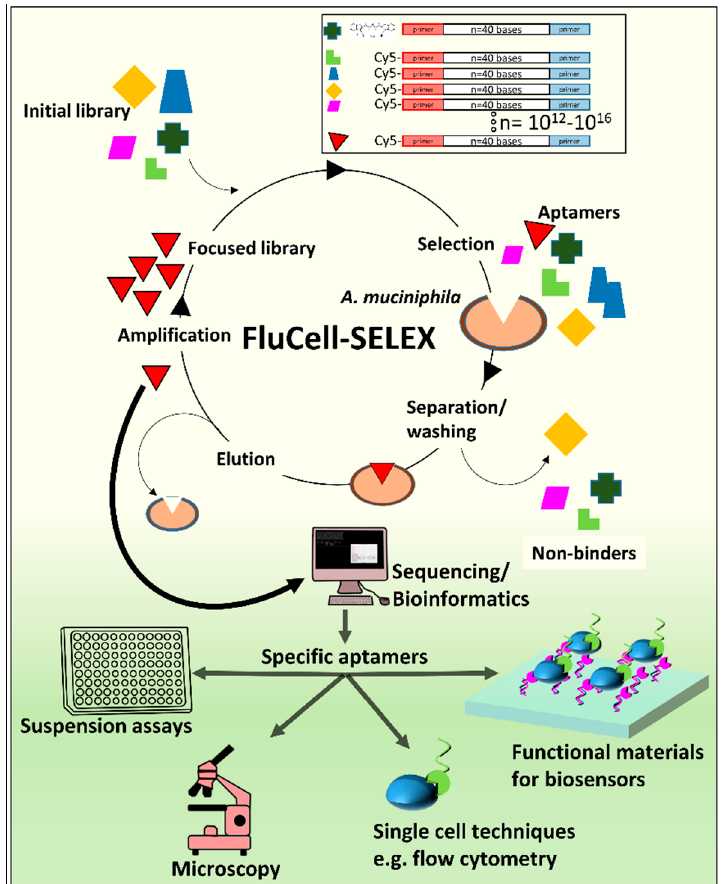
Figure 1. Selection of individual aptamers against A. muciniphila by the FluCell-SELEX [26] and their possible application in modern bioanalytical techniques. A randomized single stranded aptamer library was incubated with the target to separate binders from non-binders by simple washing and subsequent amplification of the bound aptamers to gain focused (i.e., specific) libraries. By repetition of this procedure with increasing stringency, a specific enriched polyclonal aptamer library was evolved and finally sequenced by next-generation sequencing to determine the most specific individual aptamer sequences by bioinformatics. The suitability of this aptamers in modern bioanalytical techniques including suspension assays, microscopy, flow cytometry and generation functional materials for biosensors was investigated.